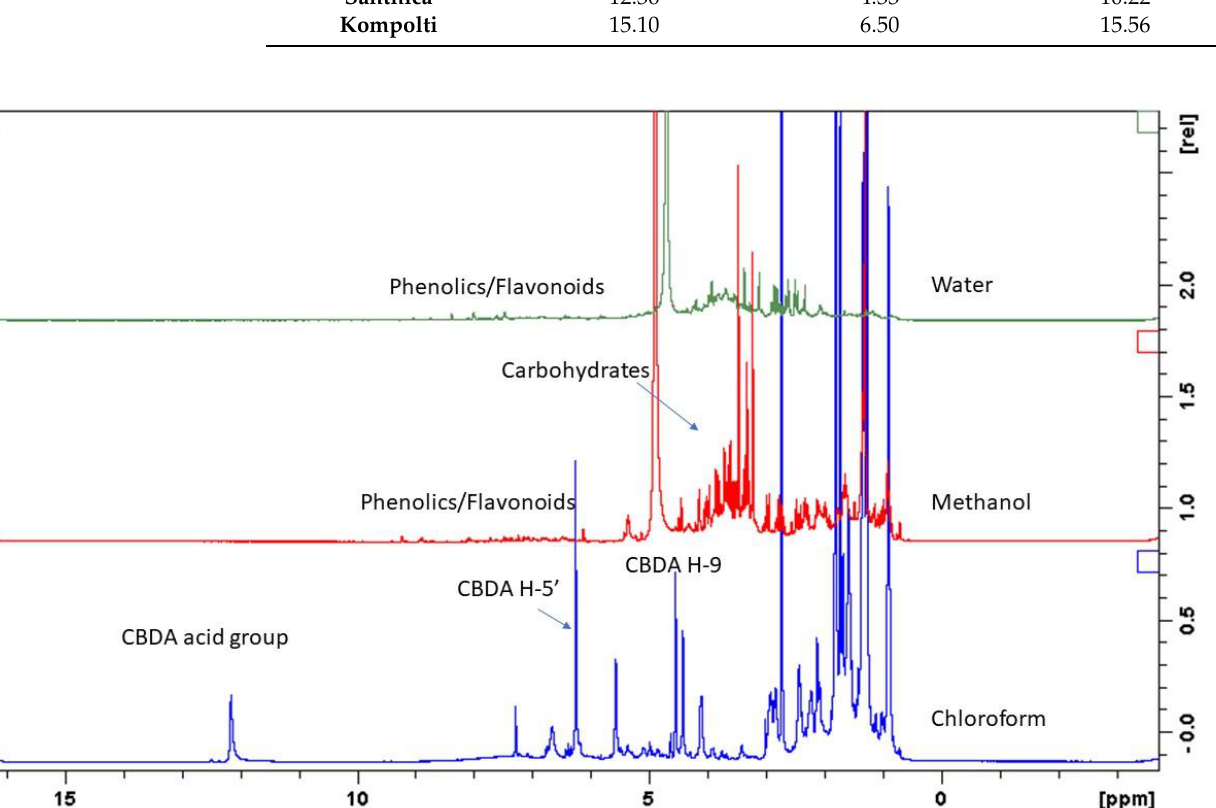
Figure 2. 1 H-NMR spectra showing the composition of UM chloroform, methanol and water ex- tracts.